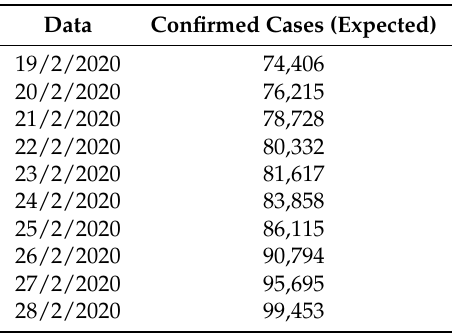
Table 5. Forecasted confirmed cases of the COVID-19 by the proposed